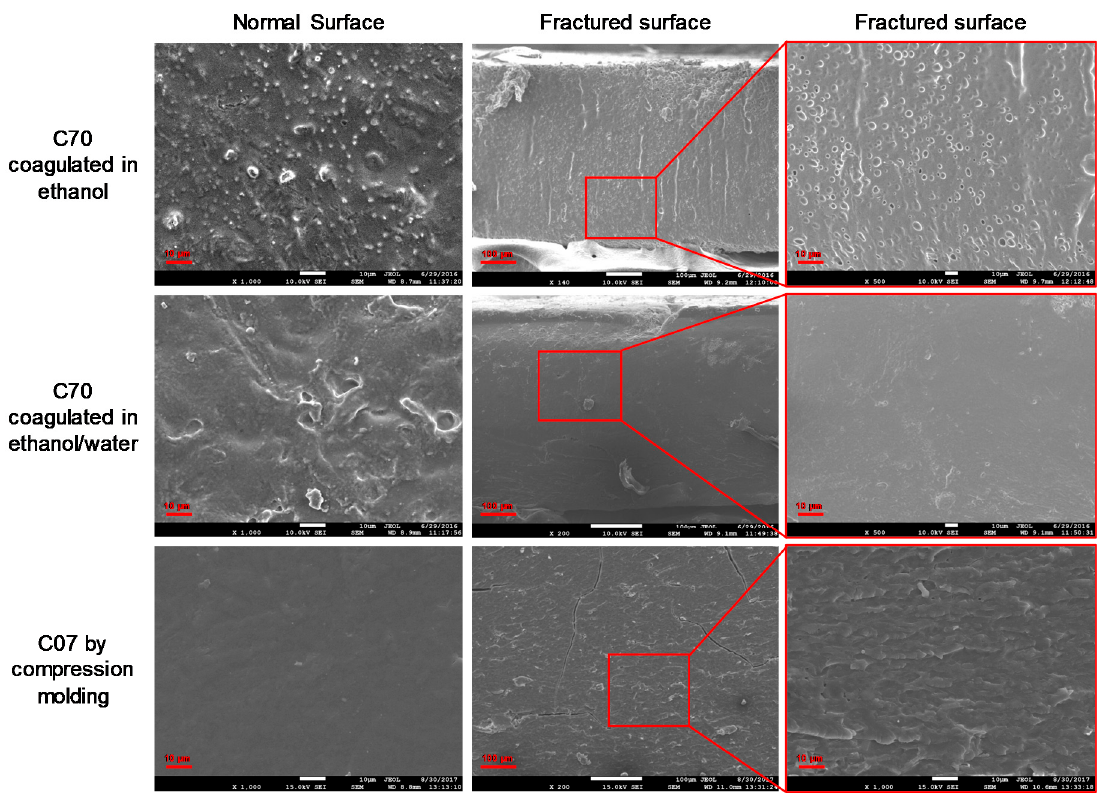
Figure 4. SEM images of cellulose-starch blend films. The magnifications are 1000 for normal-surface images and 200 and 500 for fractured-surface images.